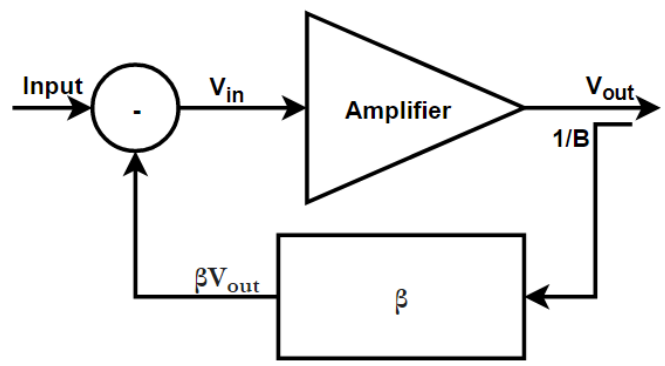
Figure 3. Simplified feedback operational diagram.